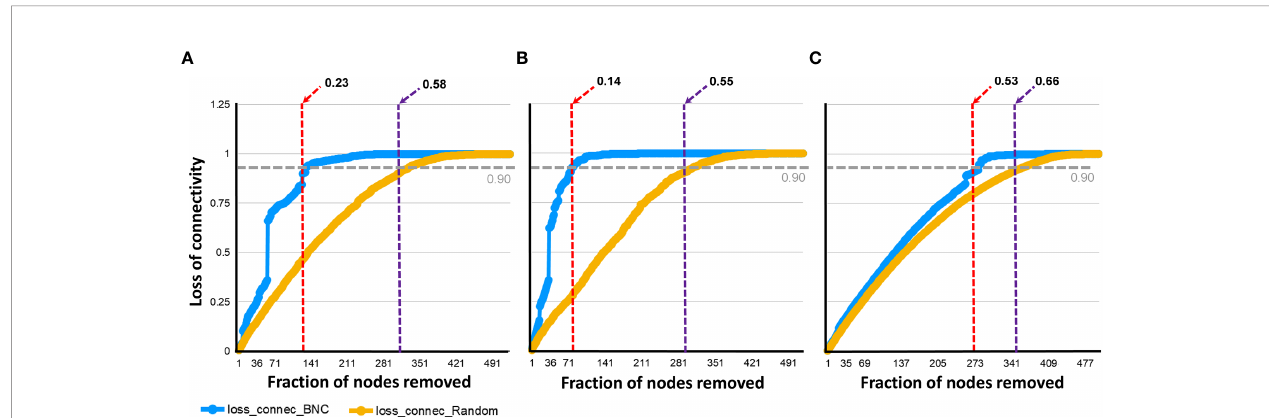
FIGURE 7 | Network tolerance to taxa removal. The resistance of the networks to directed (blue line), or random (orange line), removal of nodes was measured. The proportion of directly (red dashed line), or randomly (violet dashed line) removed nodes that made the network losing 0.90 of connectivity was recorded in the bacterial co- occurrence networks of ticks fed on mock-immunized (A) , L. mesenteroides -immunized (B) and E. coli -immunized (C) . Loss of connectivity values range between 0 (maximum of connectivity between nodes) and 1 (total disconnection between nodes) for any given